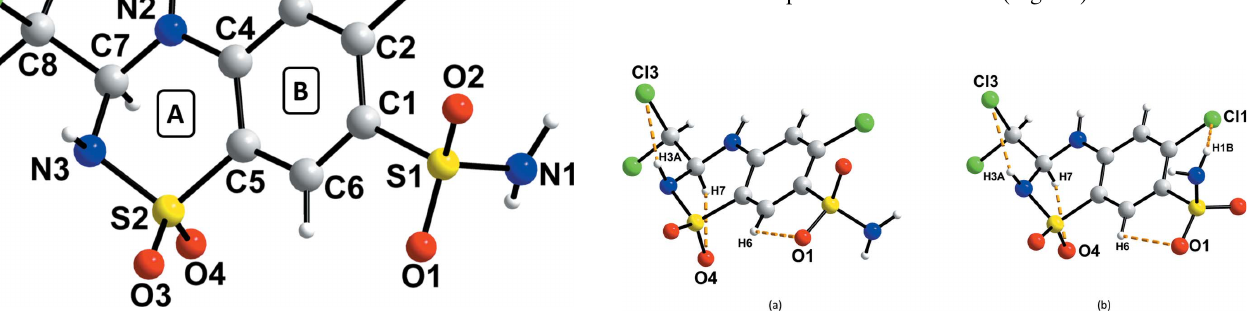
Figure 3 Intramolecular hydrogen bonds present in ( a ) RS -TCMZ and ( b ) S - TCMZ (KIKCUD).